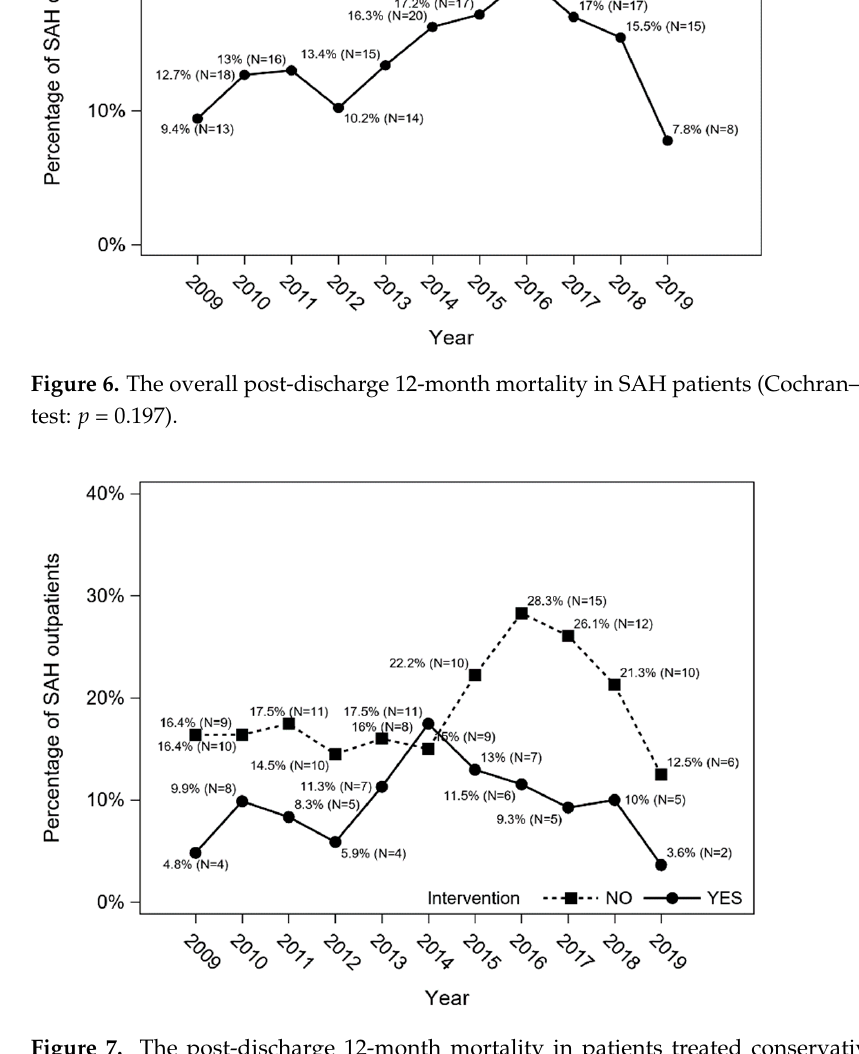
Figure 8. Overall combined mortality (in-hospital mortality and post-discharge 12-month mortality) (Cochran–Armitage trend test: p = 0.006).